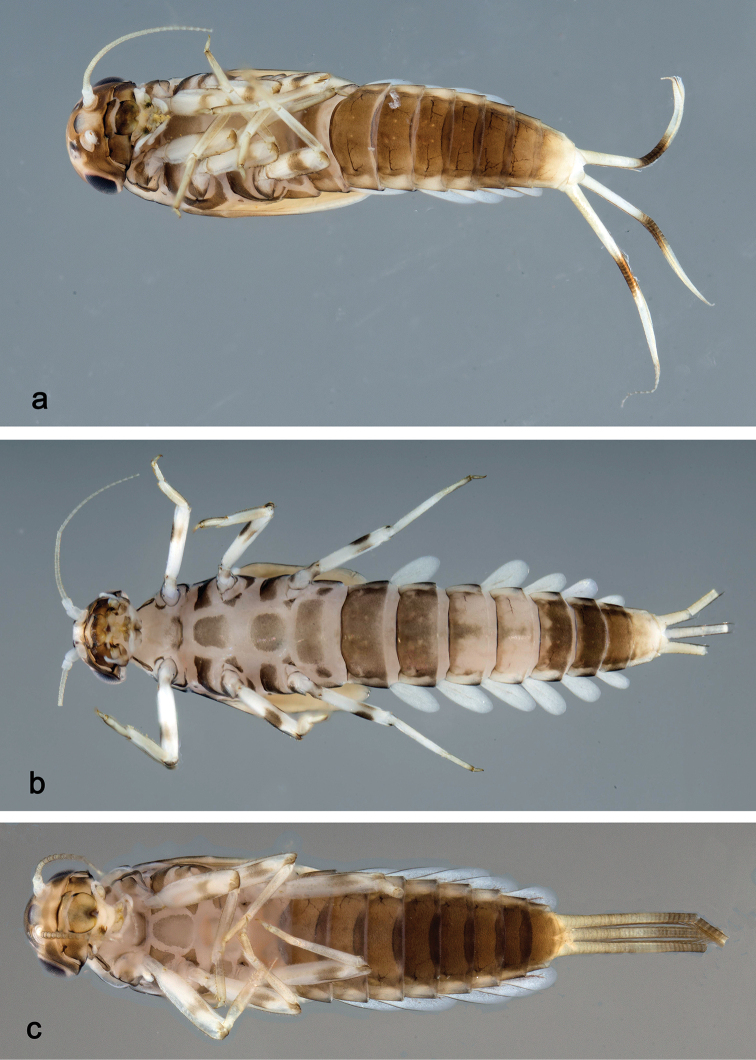
Habitus, larvae, ventral view aLabiobaetis
acei sp. nov. bLabiobaetis
aldabae sp. nov. cLabiobaetis
camiguinensis sp. nov.